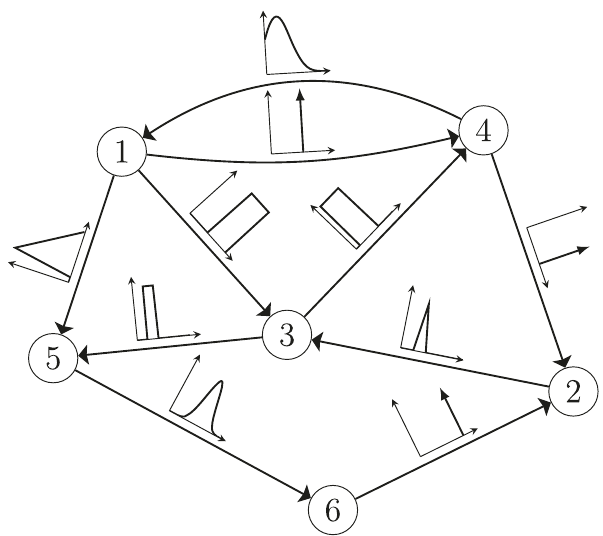
Fig. 1 A network ensemble described by edge weights each drawn from a distribution. A network with n = 6 nodes and j E j ¼ 10 directed edges. The edge weight associated with each edge is not known precisely but is instead drawn from some distribution indicated by the plots along each